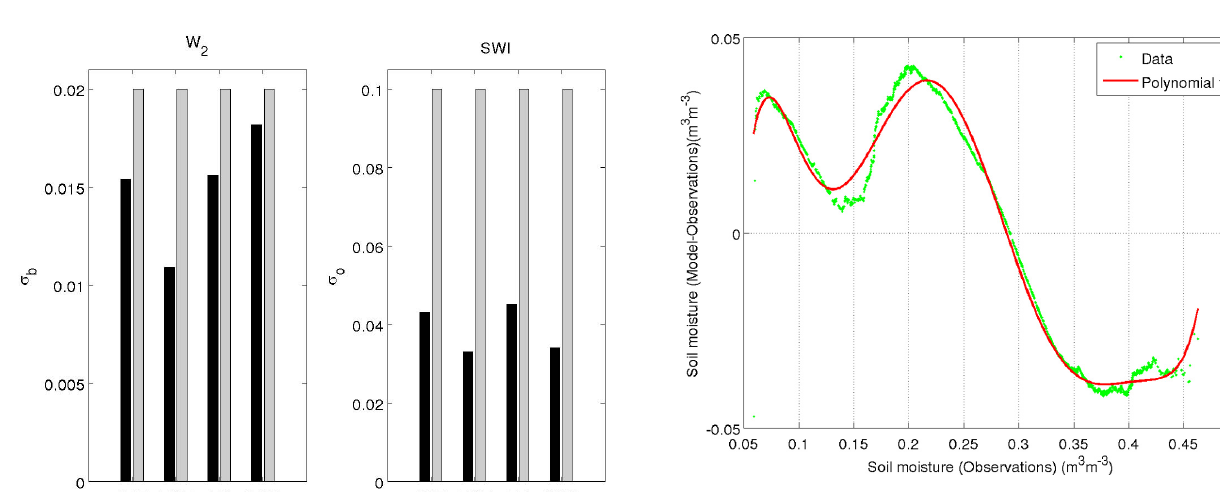
Fig. 11. Calibration of the cumulative distribution function of in situ data and simulated superficial soil moisture (m 3 m − 3 ) by a 7th-order polynomial fit over the 7-year period (2001–2007) at SMOSREX